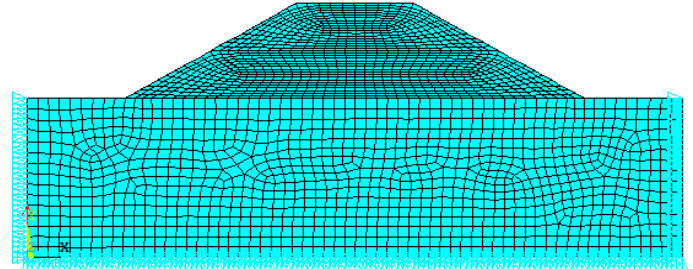
Figure 2. Finite element model of the embankment slope.